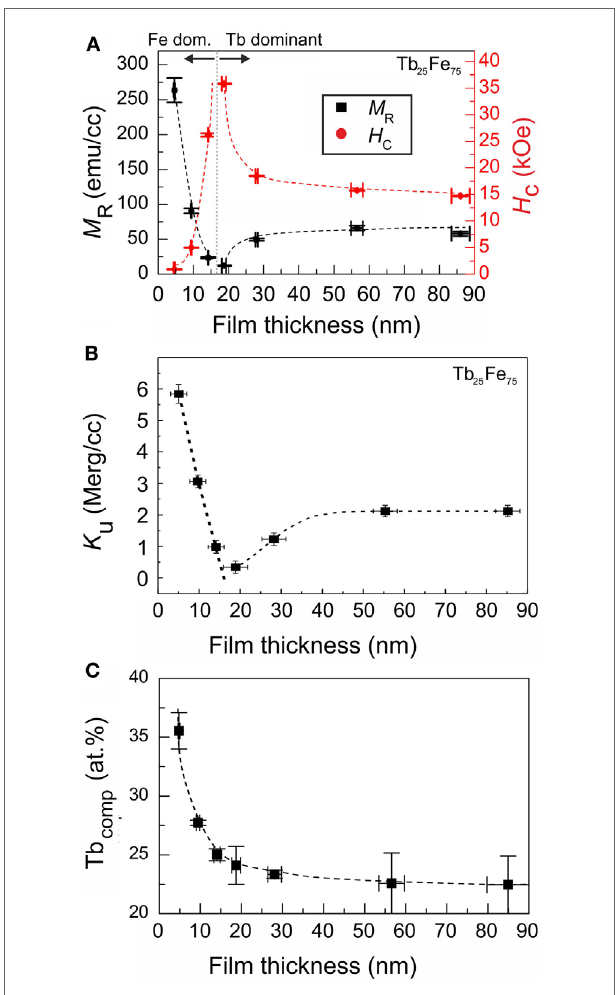
FigUre 4 | (a) Remanent sample magnetization M R and coercivity H C for Tb 25 Fe 75 films at room temperature for different film thicknesses. M R ( H C ) decreases (increases) for increasing film thickness and reaches almost zero (infinity) at the room temperature compensation film thickness of about 17 nm. For thicker films M R ( H C ) increases (decreases) again and reaches a constant value for film thicknesses larger than 30 nm. (B) Uniaxial magnetic anisotropy K u for Tb 25 Fe 75 films at room temperature as function of film thickness. (c) Room temperature compensation composition Tb comp versus magnetic film thickness. Lines are guide to the